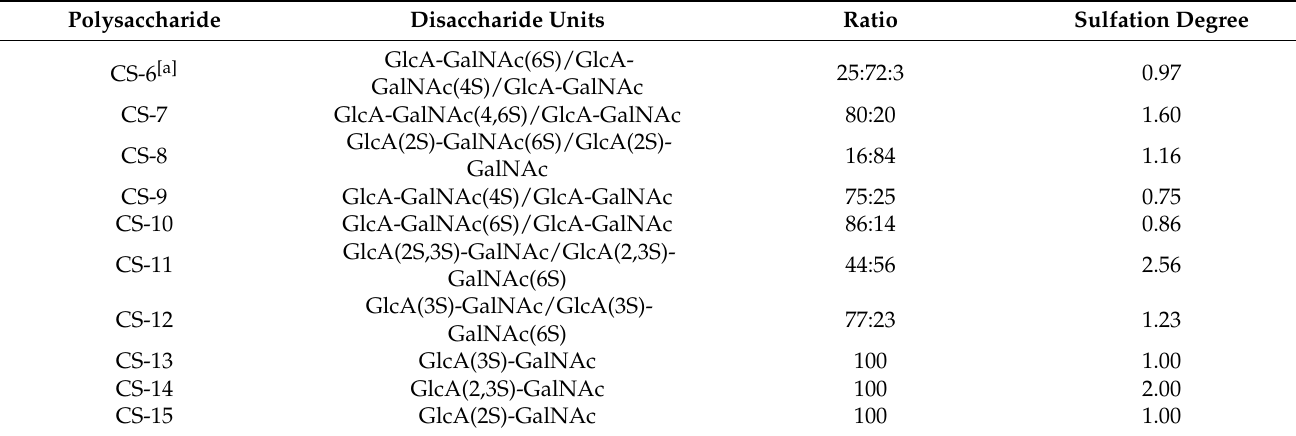
Table 2. Disaccharide composition and corresponding sulfation pattern of semi-synthetic polysaccharides.